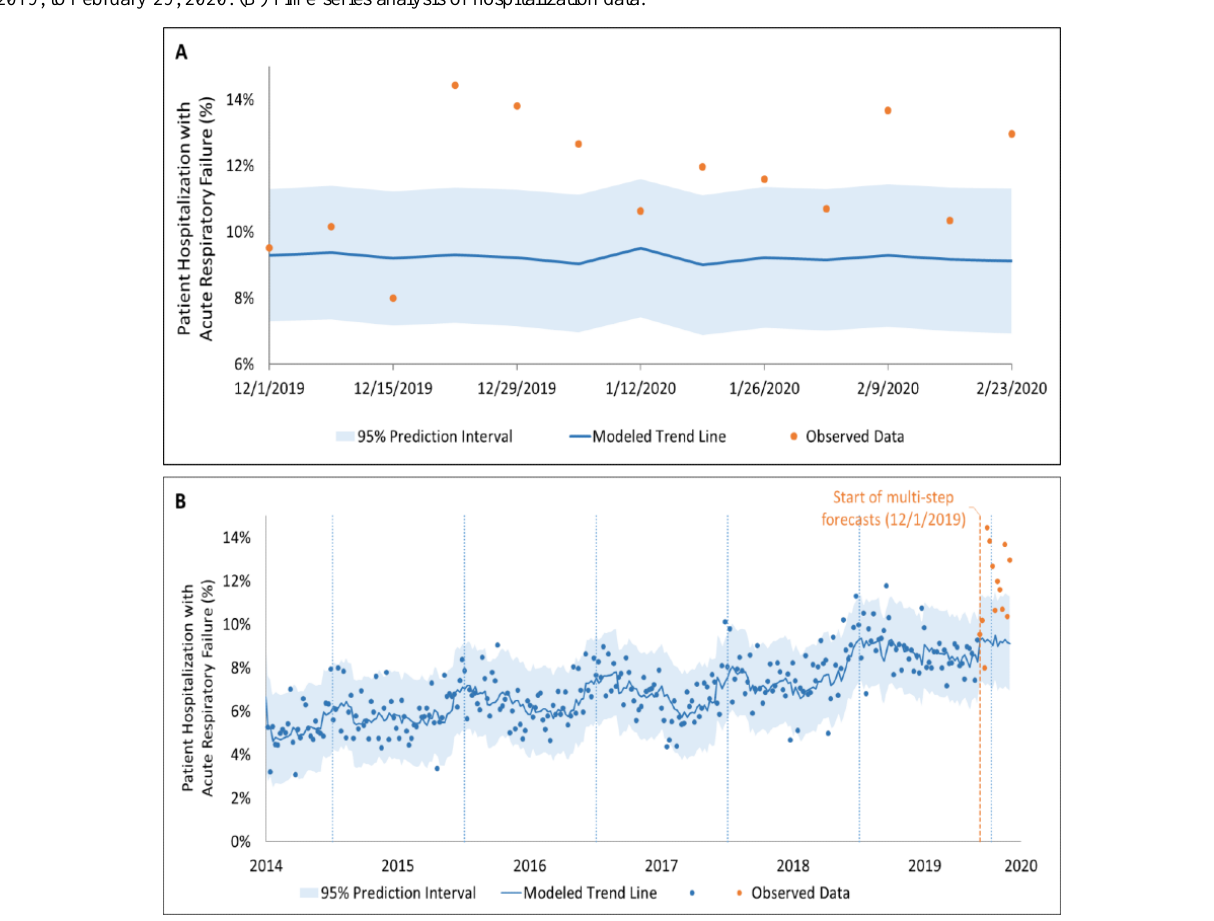
Figure 4. Time-series analyses of hospitalizations for acute respiratory failure. (A) Forecast, with 95% prediction intervals, of expected rates of patients hospitalized with acute respiratory failure (based on time-series analyses of the previous 5 years), with observed data for each week shown for December 1, 2019, to February 29, 2020. (B) Time-series analysis of hospitalization